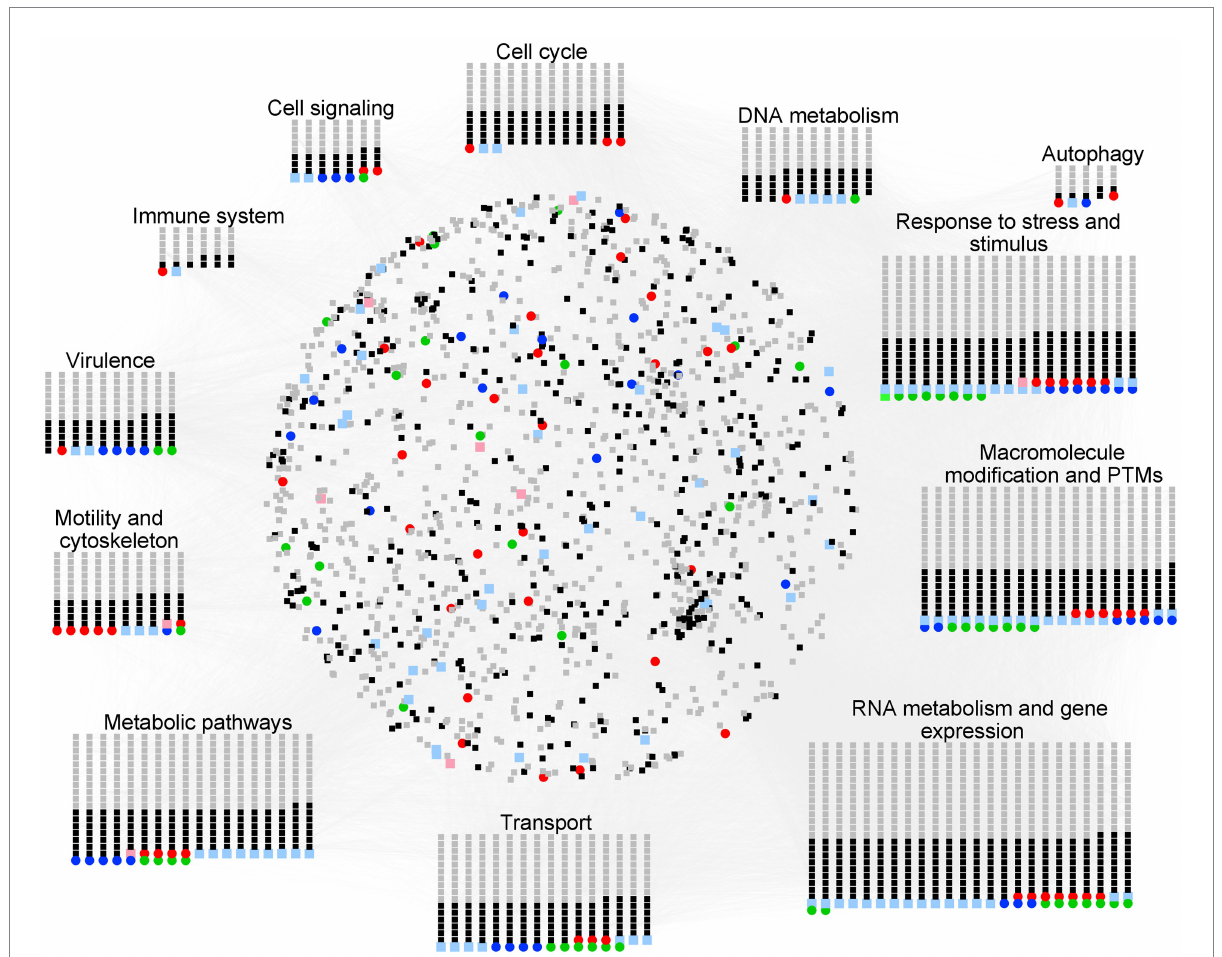
FIGURE 7 Overview of the protein–protein interaction (PPI) and functional modules identified in Naegleria pangenome. PPI network generated with STRING (using a high confidence score of 0.75 and visualized with Cytoscape) was built using information available in the STRING database. The nodes represent the genes, and the edges represent the protein interactions. Functional node clusters were created based on the results obtained with the STRING enrichment plugin (with a high confidence score of 0.75 and based on non-redundant terms of Gene Ontology (GO) term, Kyoto encyclopedia of genes and genomes (KEGG) pathway data and Reactome Pathways Functional Interaction (FI) Network); they highlight major biological processes in Naegleria . Node color code stands as red for NF, pink for genes absent in NF (but present in both NL and NG), green for NL, light green for genes absent in NL (but present in both NF and NG), blue for NG, light blue for genes absent in NG (but present in both NF and NL), black for core genes and gray for accessory (Network figures generated using